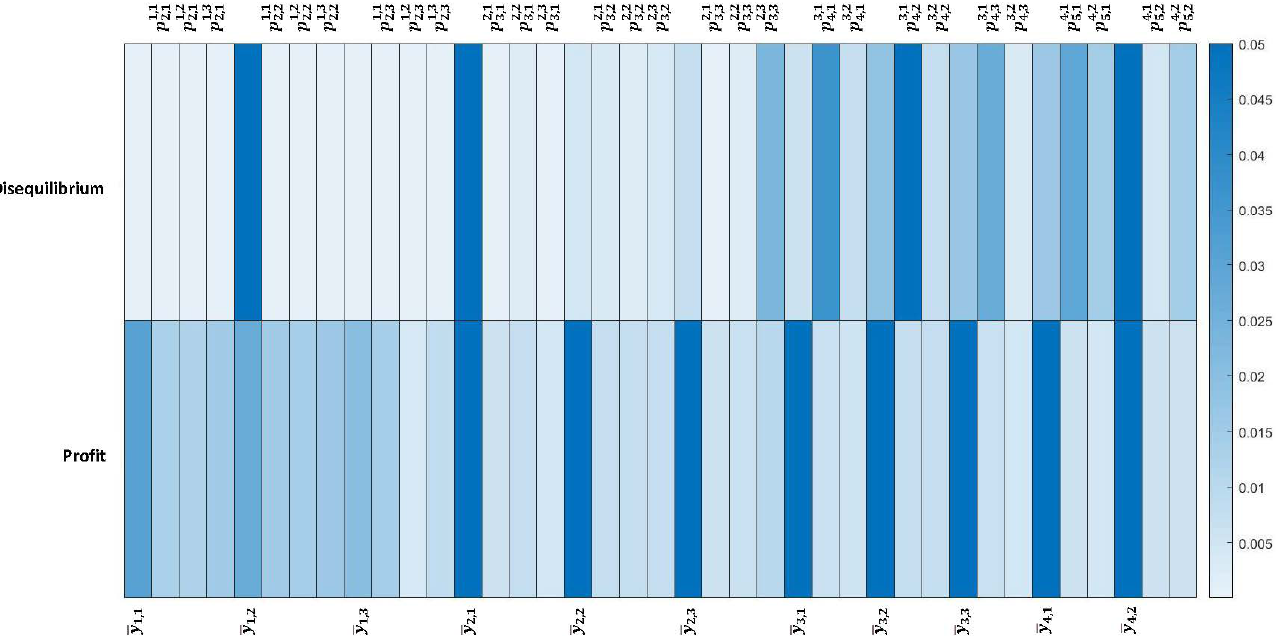
Figure 10. Sensitivity for the profit and the